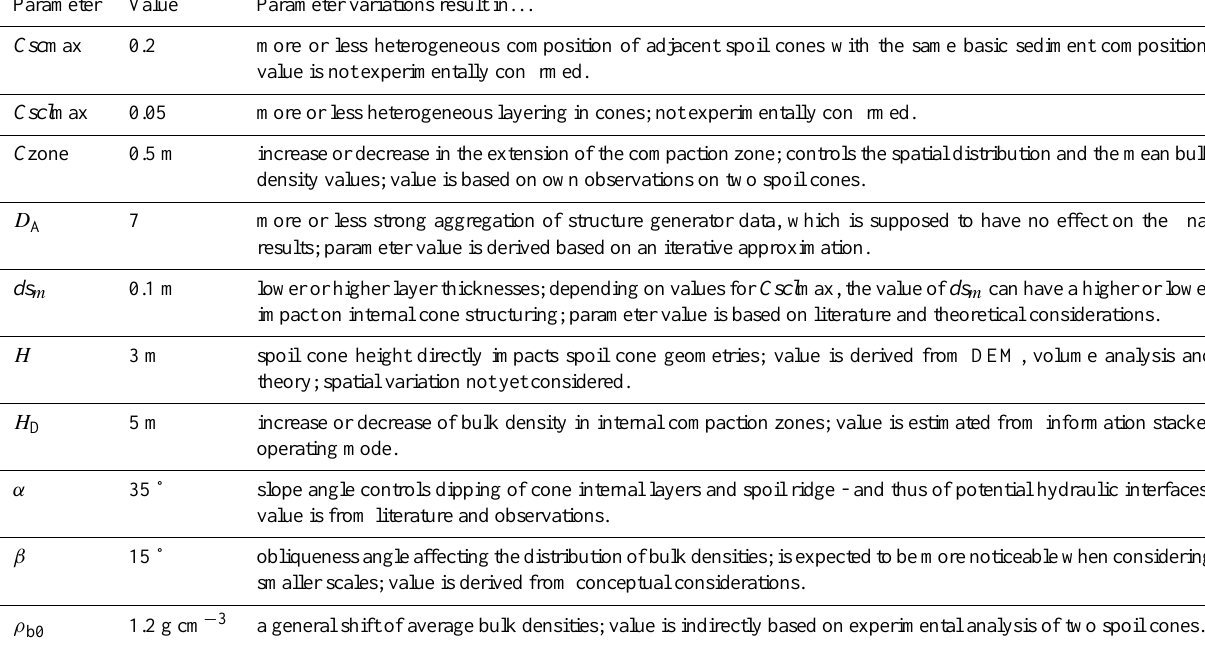
Table 4. Input parameters used in the present model scenario and qualitative assessment of parameter uncertainty regarding modeling results.